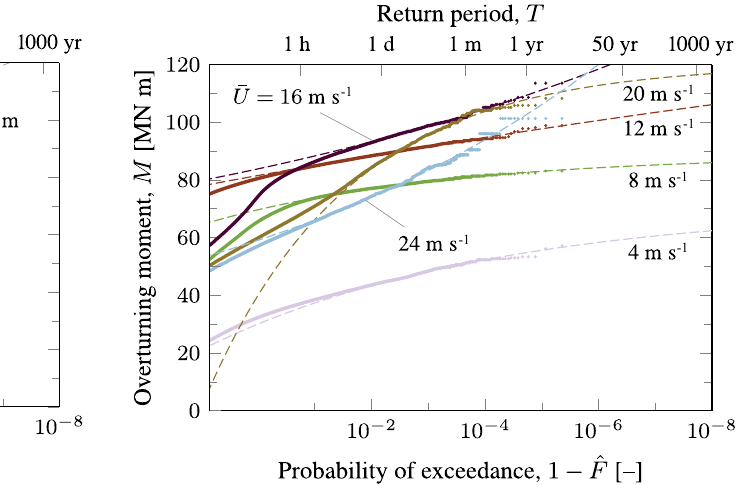
Figure 3. Return level plot of some 1ms − 1 wide bins with a GEV distribution fit after a threshold given by Eq. (6).